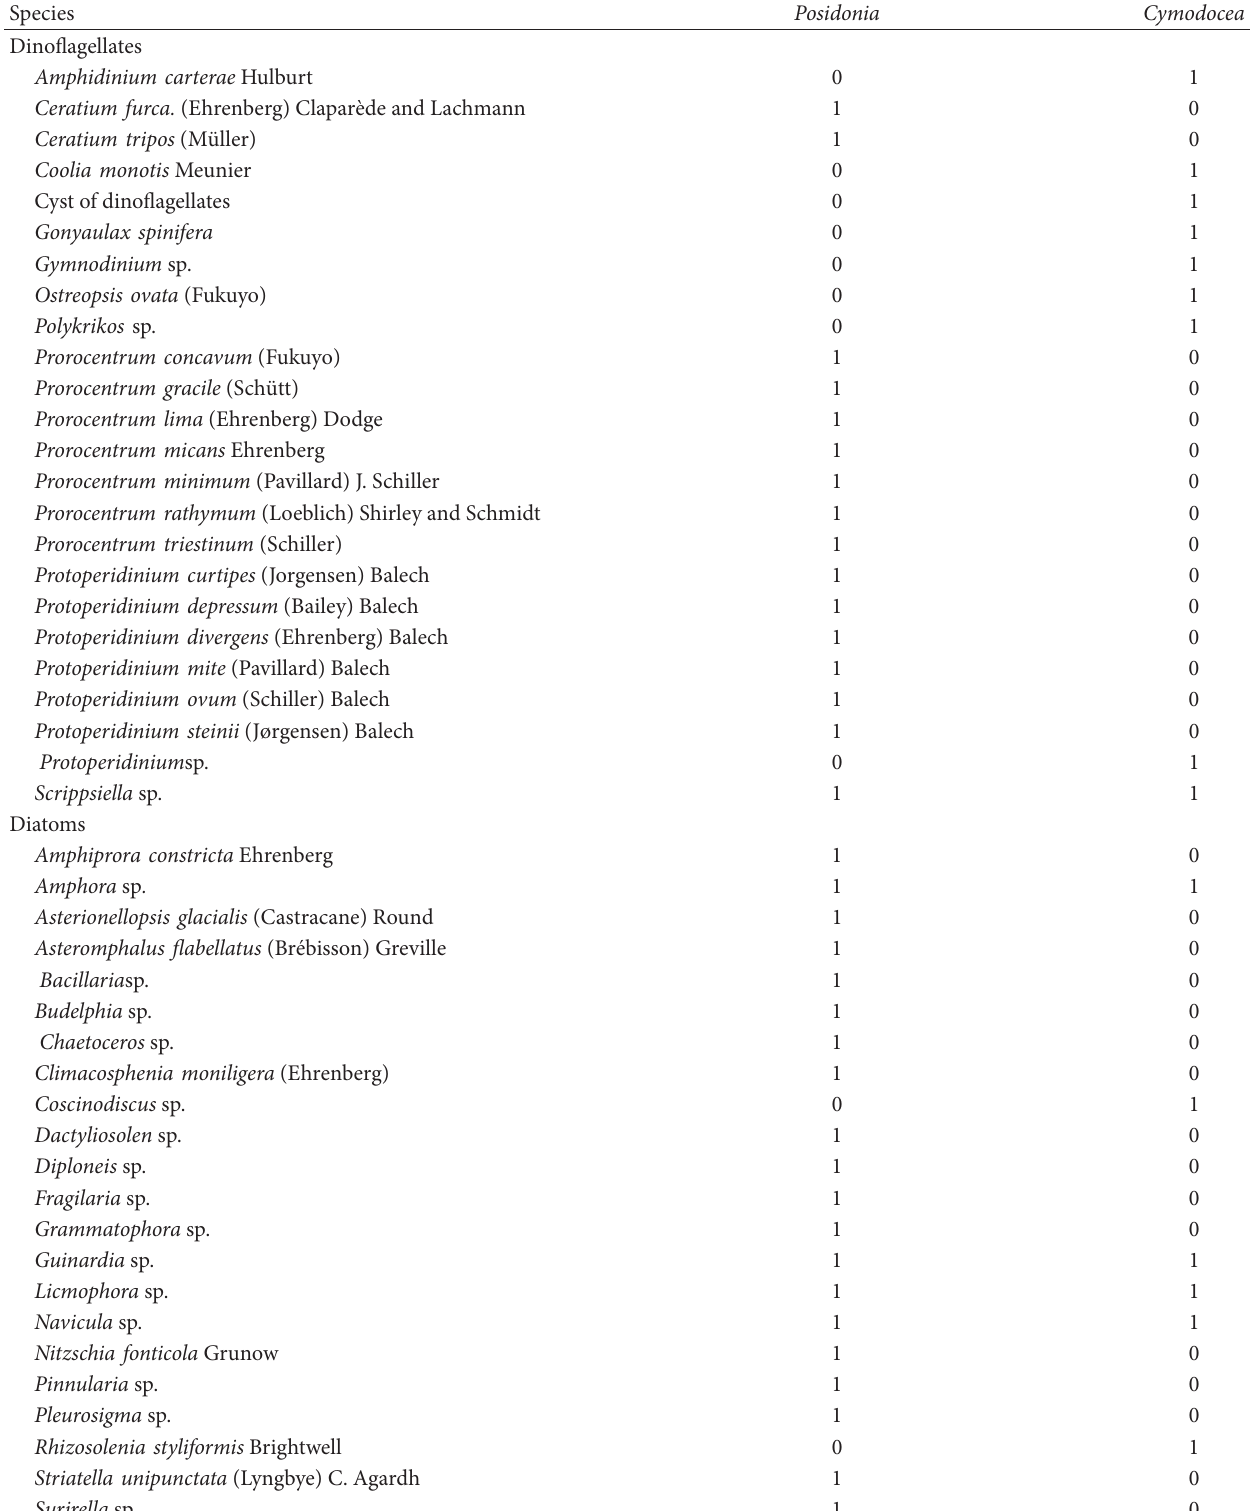
Table 1: “Presence-absence” species list of epiphytic microalgae identified on the leaves of P. oceanica and of C. nodosa in prospected stations. Species Posidonia Cymodocea